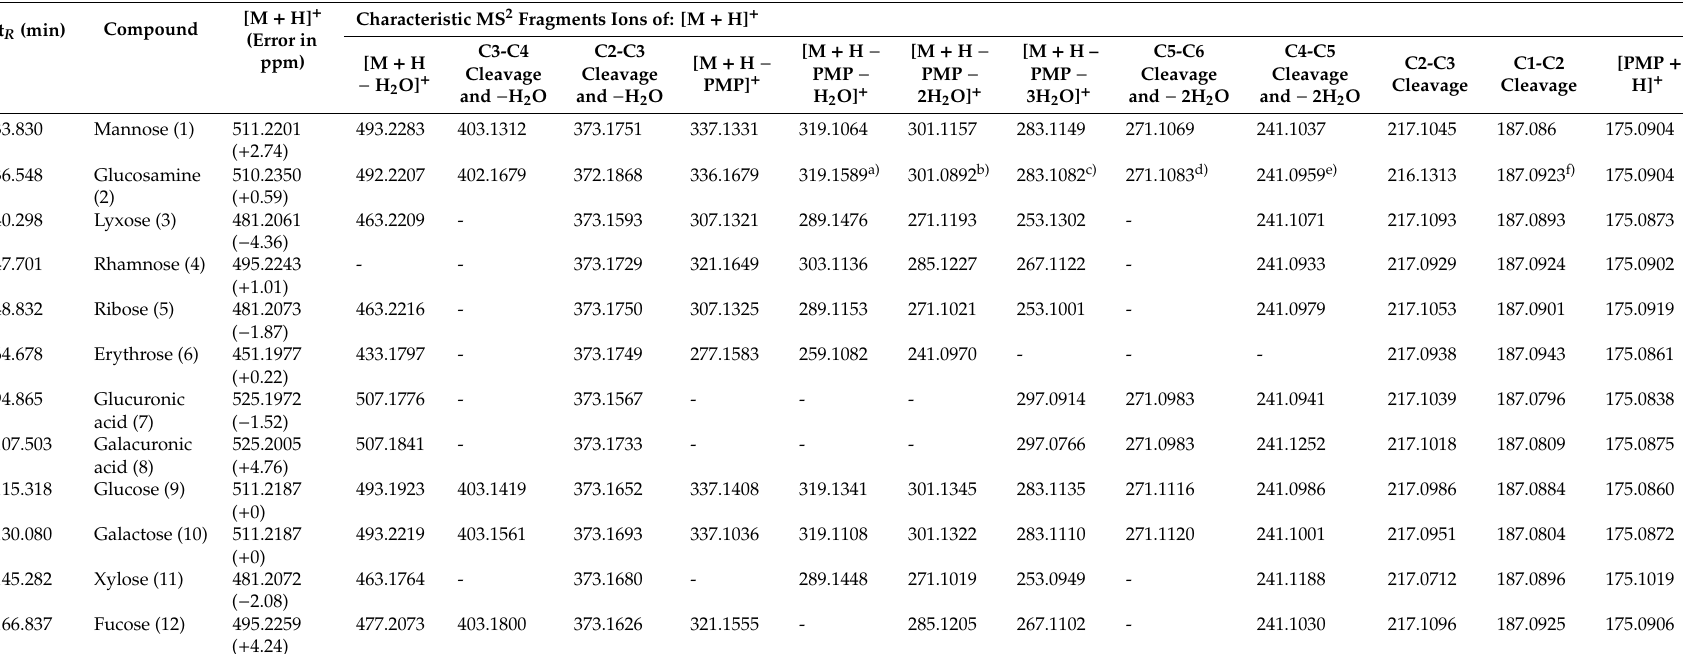
Table 1. Characteristic ions of MS / MS for PMP-labeled monosaccharides ( m / z